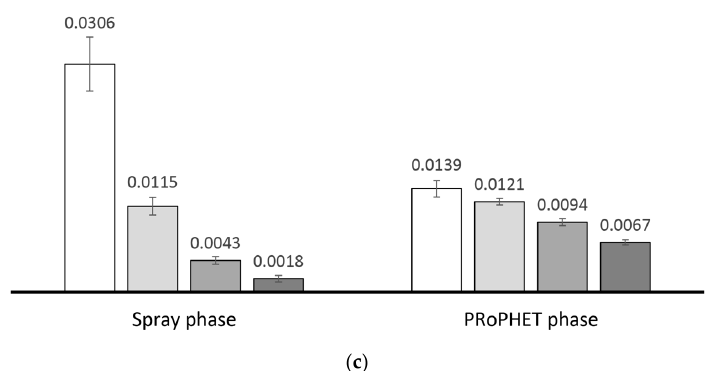
Figure 8. Average difference between the sending nodes’ and receiving nodes’ forwarding utilities for messages traversing 0, 1, 2 and 3 regions, under ( a ) low ( b ) medium and ( c ) high degree of spatial locality, with PRoPHET using fixed-quota replication (L = 8).